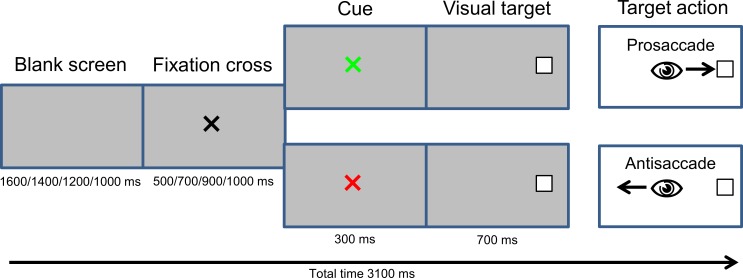
Timing of a prosaccade and an antisaccade trial.